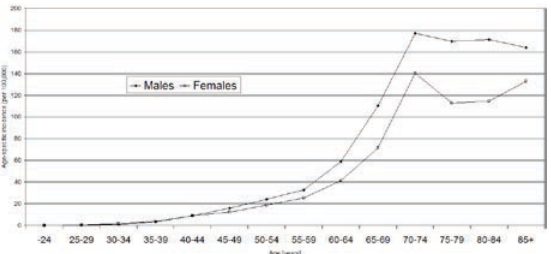
Figure 4. Age-specific incidence (per 100,000) of colon cancers diagnosed between 1984 and 2003 in Lower Silesia.